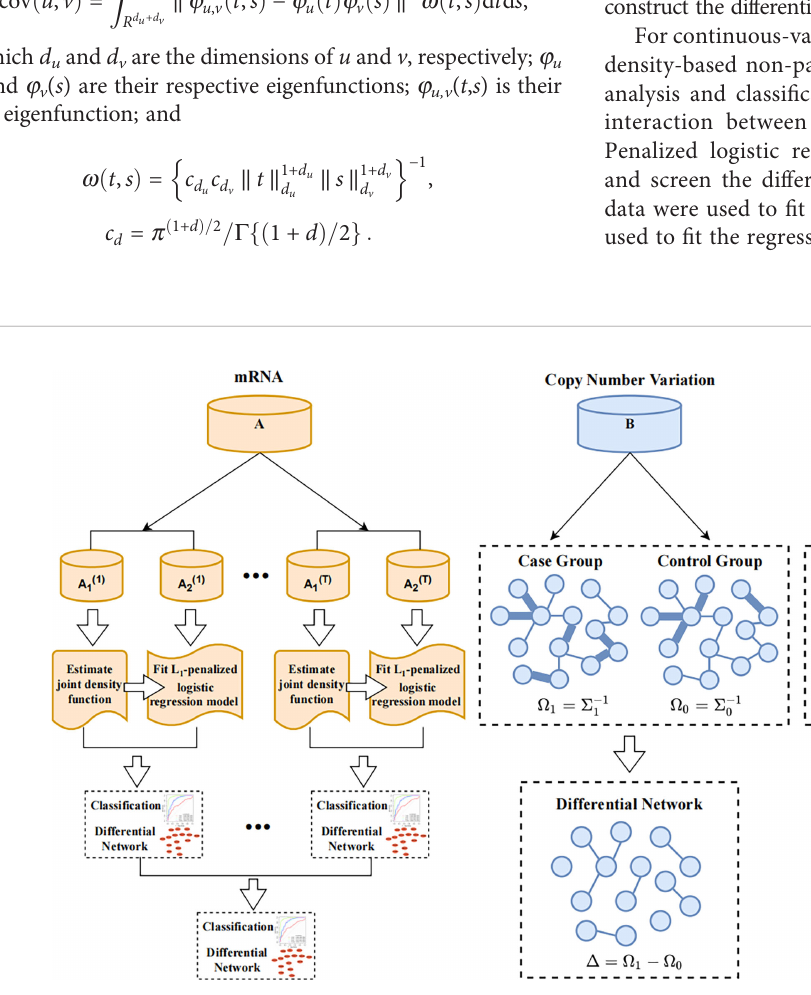
FIGURE 2 | Flow chart of JDINAC and LGCDG method. A – C represent mRNA expression, copy number variation, and somatic mutation